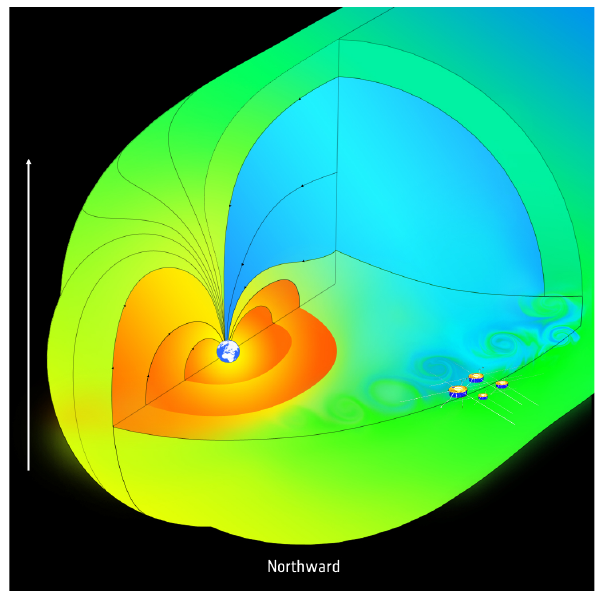
Figure 7. Sketch of Kelvin–Helmholtz waves developing on the flank of the magnetosphere 2 Fig. 7. Sketch of Kelvin–Helmholtz waves developing on the flank near the equatorial plane under Northward interplanetary magnetic field. 3 of the magnetosphere near the equatorial plane under northward in- terplanetary magnetic